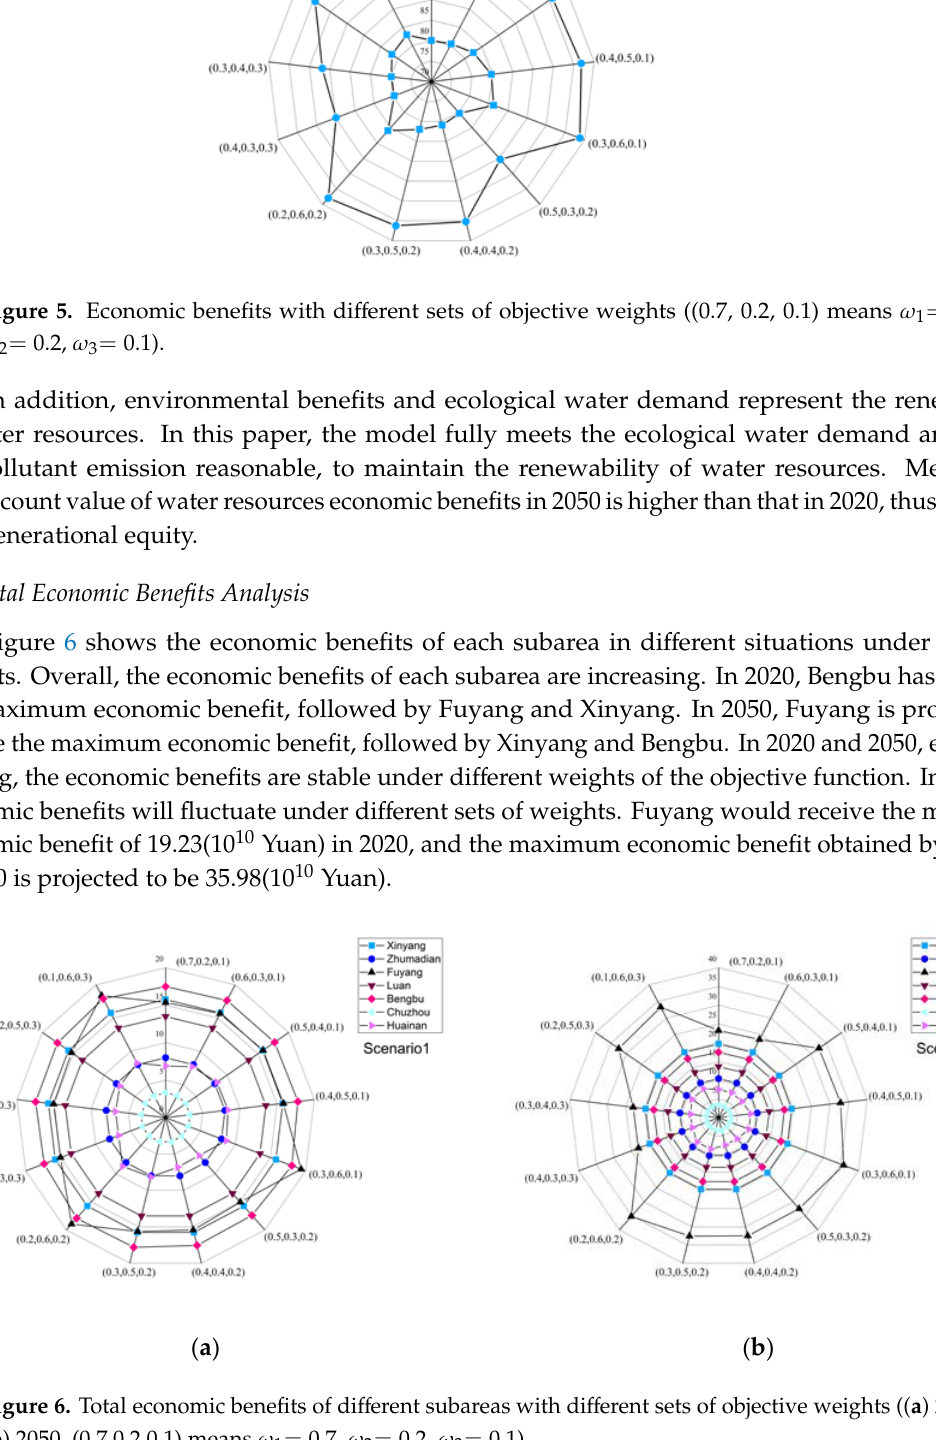
=0.2 ω , =0.7 ω , =0.1 ω ). 1 2 3